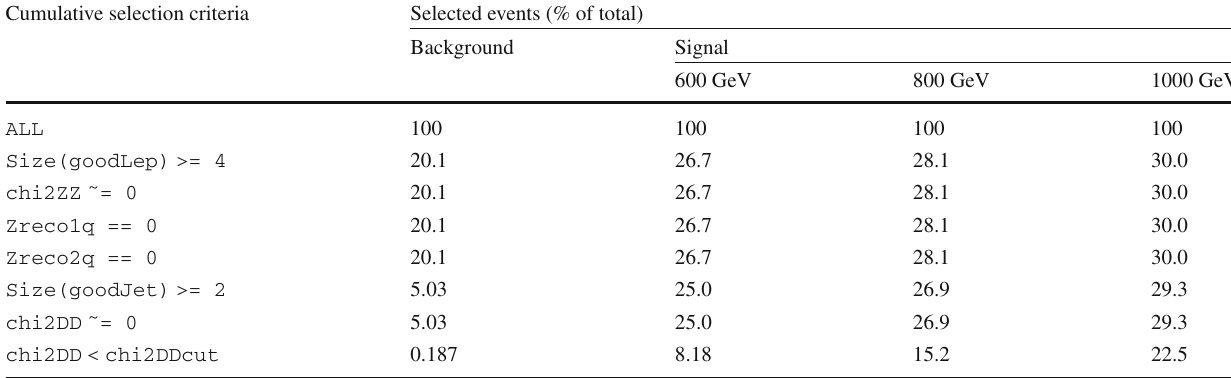
Table 2 Percentage selection efficiencies for various signals and background for the HL-LHC selection Cumulative selection criteria Selected events (% of total)